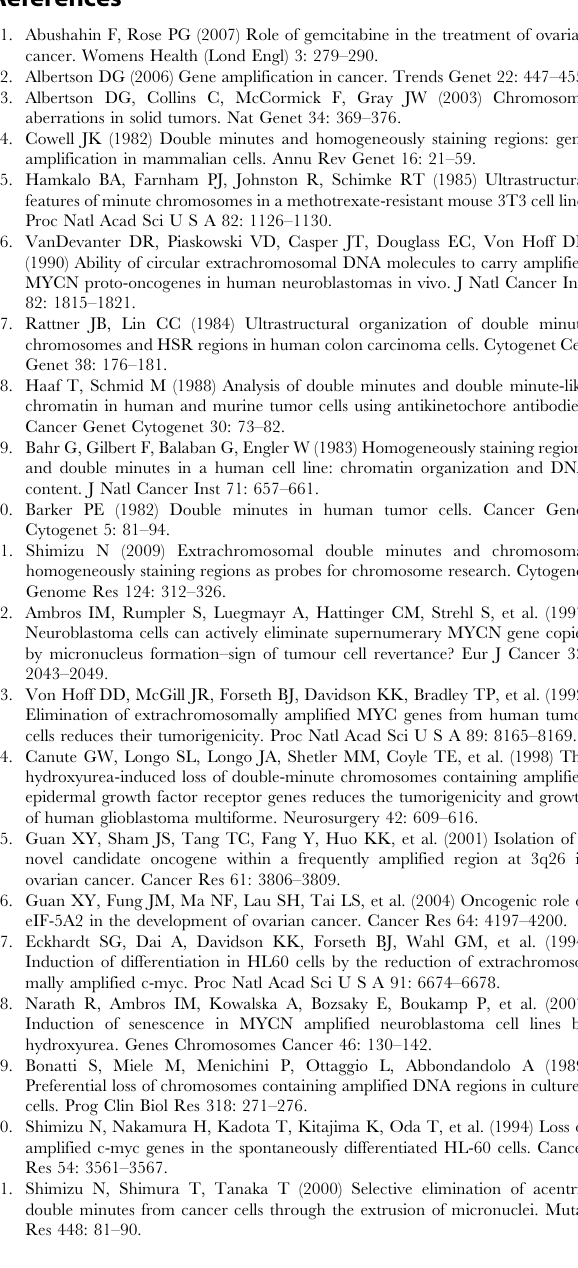
Table S1 MN and MN ( EIF5A2 + MYCN + MCL1 + ) frequency of HU and GEM treated UACC-1598-4 (DOC) Table S2 MN and MN ( c - H2AX + ) frequency of HU and GEM treated UACC-1598-4 (24 hours after release) (DOC)